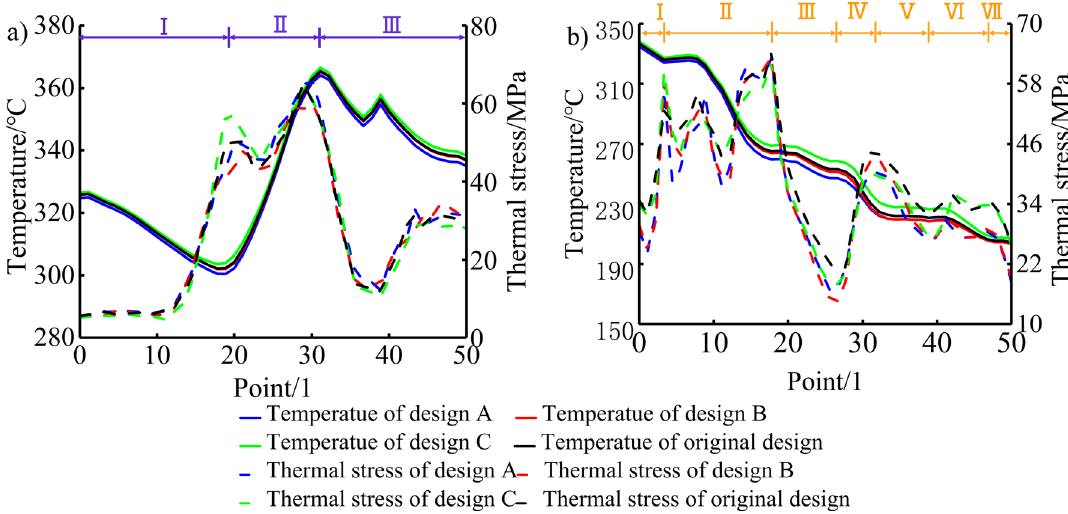
Figure 14. Temperature and thermal stress distribution of the ( a ) top surface and ( b ) piston ring